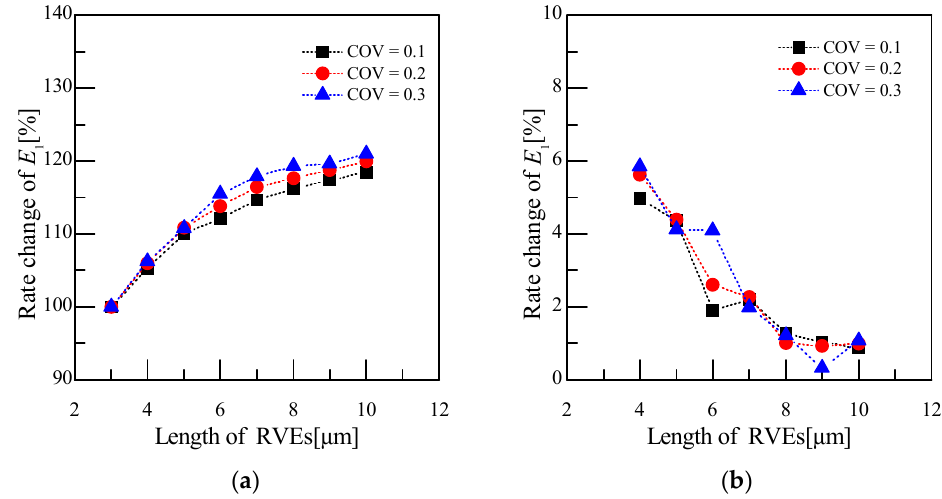
Figure 15. Changes in the effective properties according to changes in the COV: ( a ) rate of increase in the effective properties based on a 3 µm RVE according to an increasing RVE length; ( b ) difference in the increasing rate of the effective properties according to the increasing RVE length.